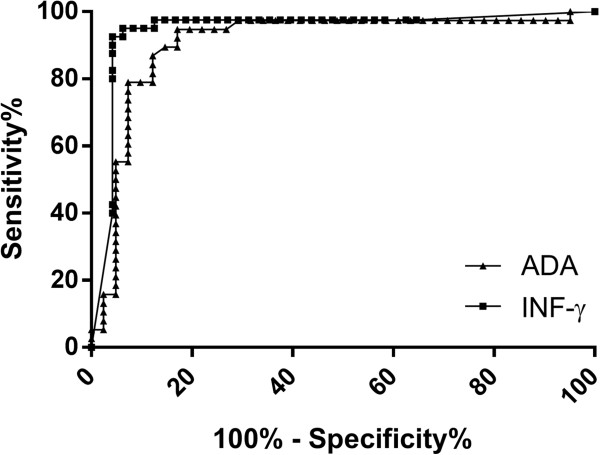
Area under the receiver operator characteristic (ROC) curves for interferon gamma (IFN-γ) and adenosine deaminase (ADA) were 0.94 and 0.91, respectively.